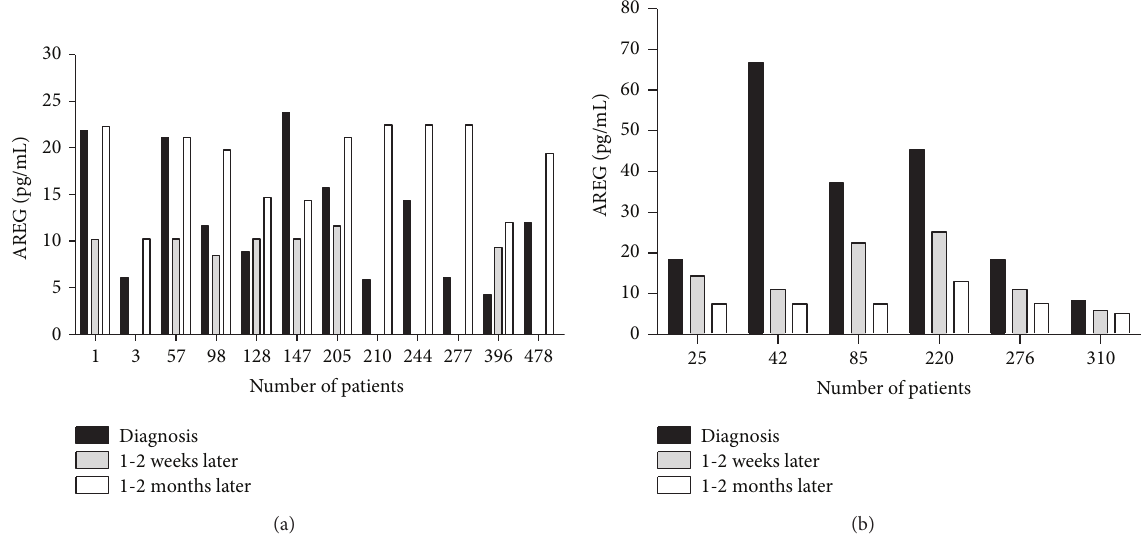
Figure 4: (a) Twelve patients with HCC who underwent postoperative adjunctive therapy during two-year follow-up. At last all of them had tumor recurrence or metastasis, and some of them were dead. The sample of postoperation 1-2 weeks of patients number 3/210/277 was not collected; (b) levels of sera AREG from another six HCC patients were showed after operation and during follow-up.